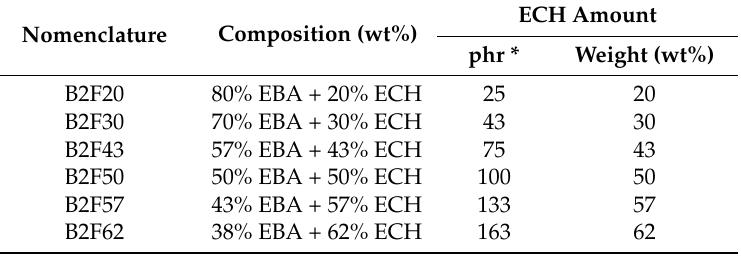
Table 2. Composition of the EBA copolymer + hydrogenated glycerol rosin ester (ECH) resin binary